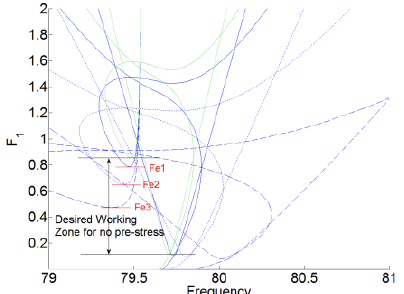
Figure 4. The desired working zone for the membrane nonlinear energy sink (NES) with three different pre-stress. The green and solid lines represent no the pre-stress. The blue and solid lines are for f 1 = 30 Hz . The blue and dotted lines are for f 1 = 50 Hz . The blue and dashed lines are for f 1 = 65 Hz .